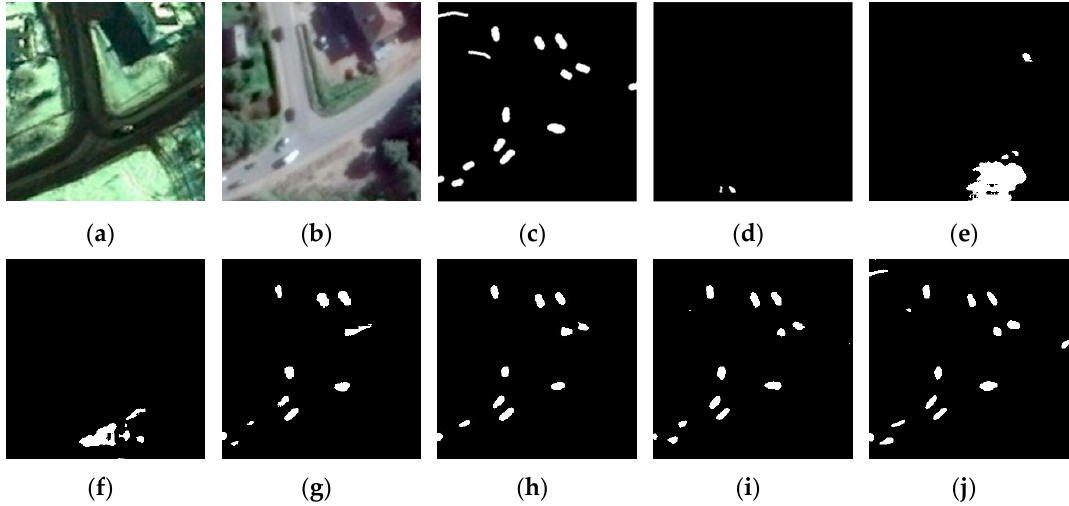
Figure 9. Visual comparison of change detection results in area 4: ( a ) T1 image, ( b ) T2 image, ( c ) ground truth, ( d ) FC-EF, ( e ) FC-Siam-conc, ( f ) FC-Siam-diff, ( g ) UNet++_MSOF, ( h ) IFN, ( i ) SNUNet-CD/32, ( j ) proposed method. The changed areas are marked by white, and the unchanged areas are marked by black.